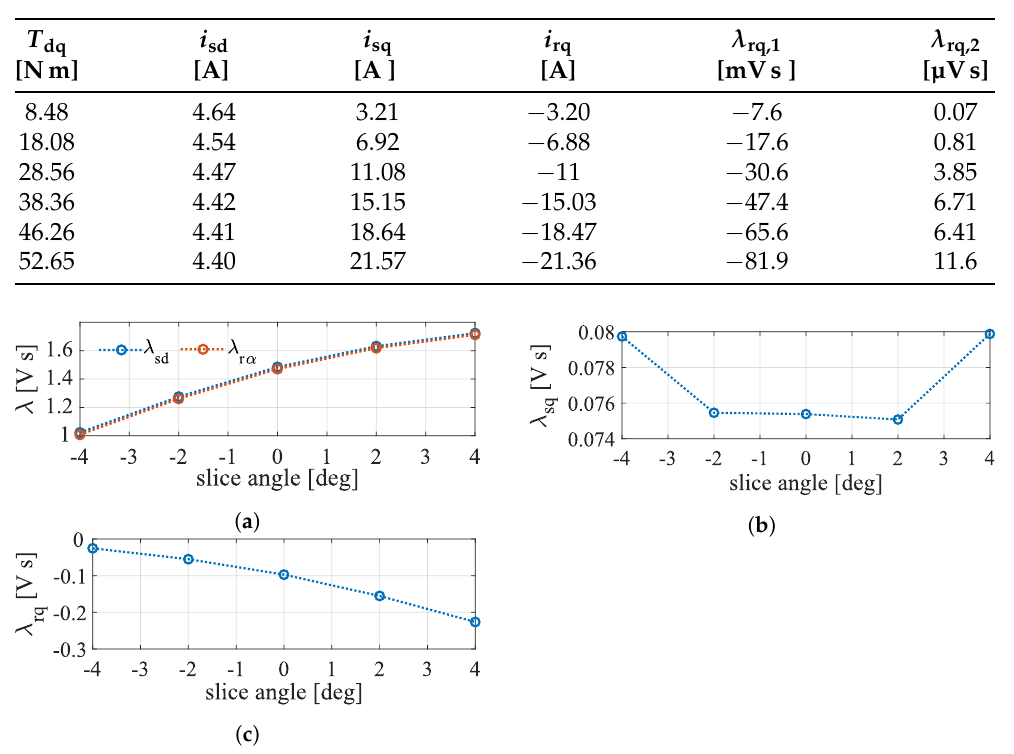
Figure 7. Stator and rotor flux linkage behavior, with the motor moving forward and backward and its electric load. These results come from the first step of the RFOA procedure with i rq = Stator d -axis flux linkage in several slices; ( b ) stator q -axis flux linkage in several slices; ( c ) rotor q -axis flux linkage in several slices. It is the flux linked with the winding with axis β r ( λ rq = λ r β each slice).